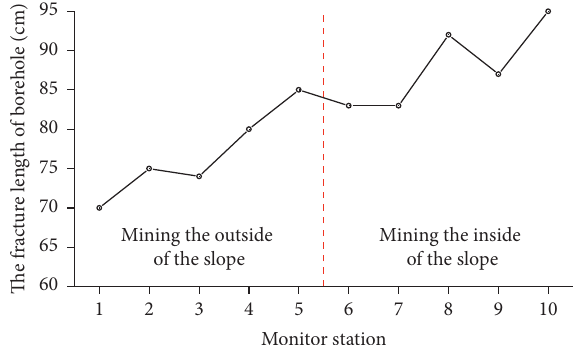
Figure 13: The peep borehole fracture development location line diagram.